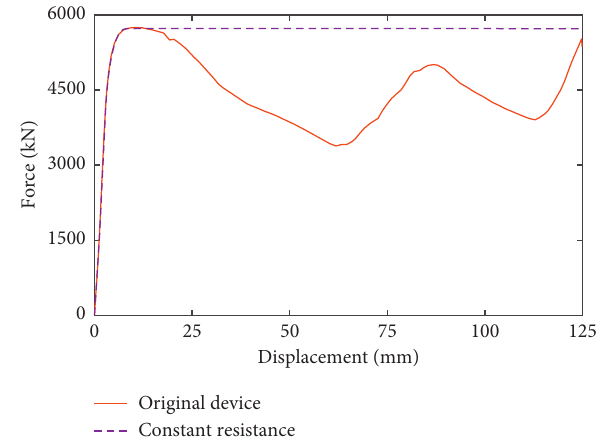
Figure 9: Load-displacement curve of the constant resistance